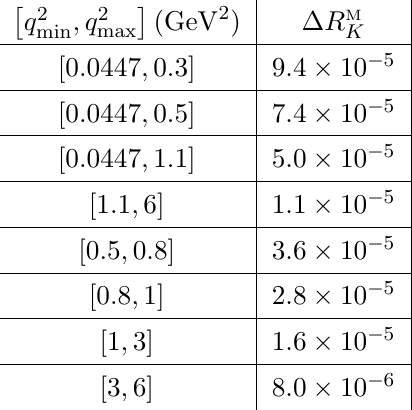
Table 6 . Results for (cid:1) R M , the relative QED radiative correction in R K for B ! K‘ + ‘ (cid:0) induced K by the magnetic-dipole corrections as de(cid:12)ned in the text, for a representative set of integrated q 2 bins in the range q 2 < q 2 < q 2 max min